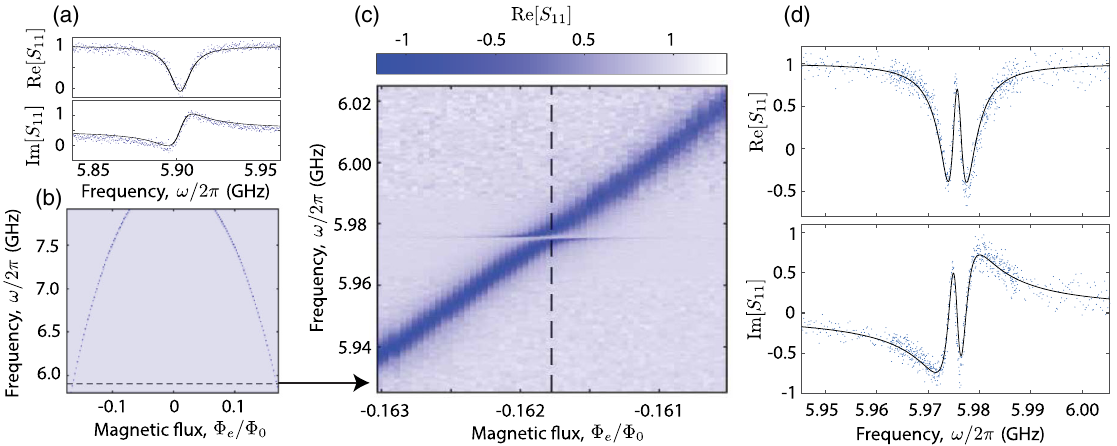
= 2 π ¼ 5 . 90 GHz, FIG. 3. Linear spectroscopy. (a) Reflection spectrum S 11 ð ω Þ of the SQUID-array resonator tuned to a frequency of ω r including the raw data and the fit to the model (solid lines). The data are normalized to a spectrum collected with a very large probe power ( P ¼ 0 dBm, nominal VNA output), where the nonlinear resonance is saturated and absent from the spectrum. At this frequency, we obtain = 2 π ¼ 6 . 3 MHz. (b) Linear spectroscopy of the resonator with varying external flux. The resonator decay rates κ = 2 π ¼ 11 MHz and κ e = 2 π ¼ 8 . 31 GHz.(c)Close-up resonanceisobservedtotunewiththeexternal flux Φ intheusualwayandhasa maximumfrequency ω e r; max at the frequency indicated by the black dashed line in the wider tuning plot. An anticrossing of the microwave resonance and a mechanical = 2 π ¼ 5 . 9754 GHz is clearly observed, with the mechanical feature only visiblewhen the resonator is tuned in close mode at frequency ω m proximity. The data are collected at a higher frequency resolution within a 25-MHz band around the mechanical frequency in order to better resolve the mechanical mode away from resonance. Thevalue of Φ at which the two modes are directly on resonance is marked by a black e dashed line. (d) Line cut at the resonance, showing the two dips observed in the reflection spectrum. A least-squares fit (solid black lines) is overlaid with the raw data, showing close agreement with the